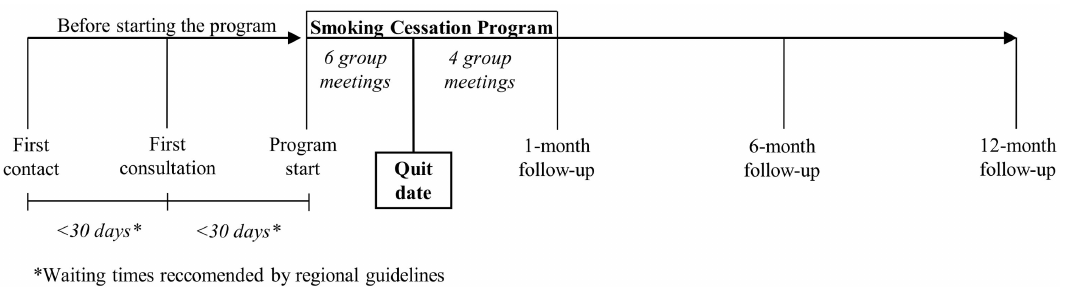
Figure 1. Steps towards stopping smoking at the smoking cessation service of Reggio Emilia (Northern